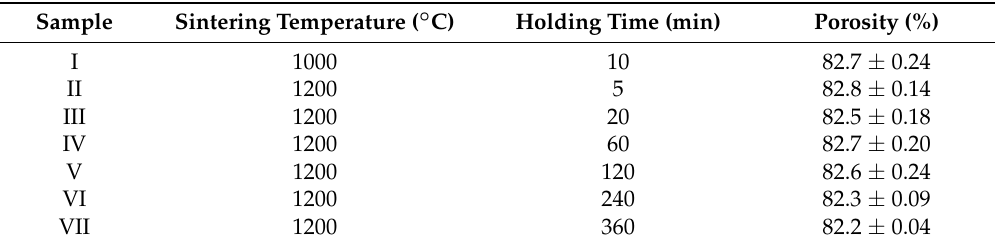
Table 1. 316L stainless steel fiber felts (SSFFs) fabricated at different sintering parameters.